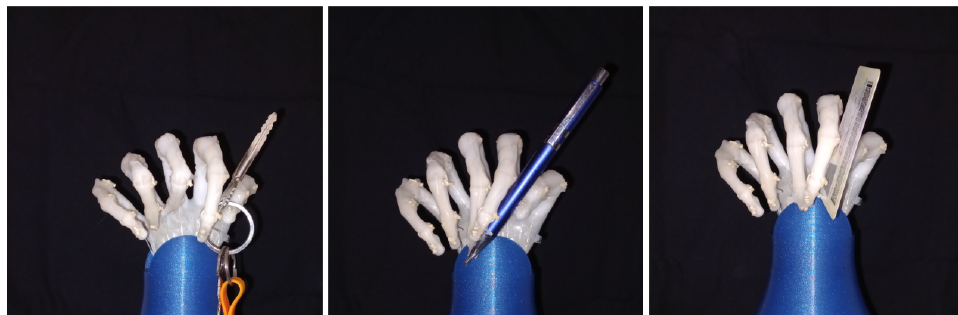
Figure 12. Precision grip of different